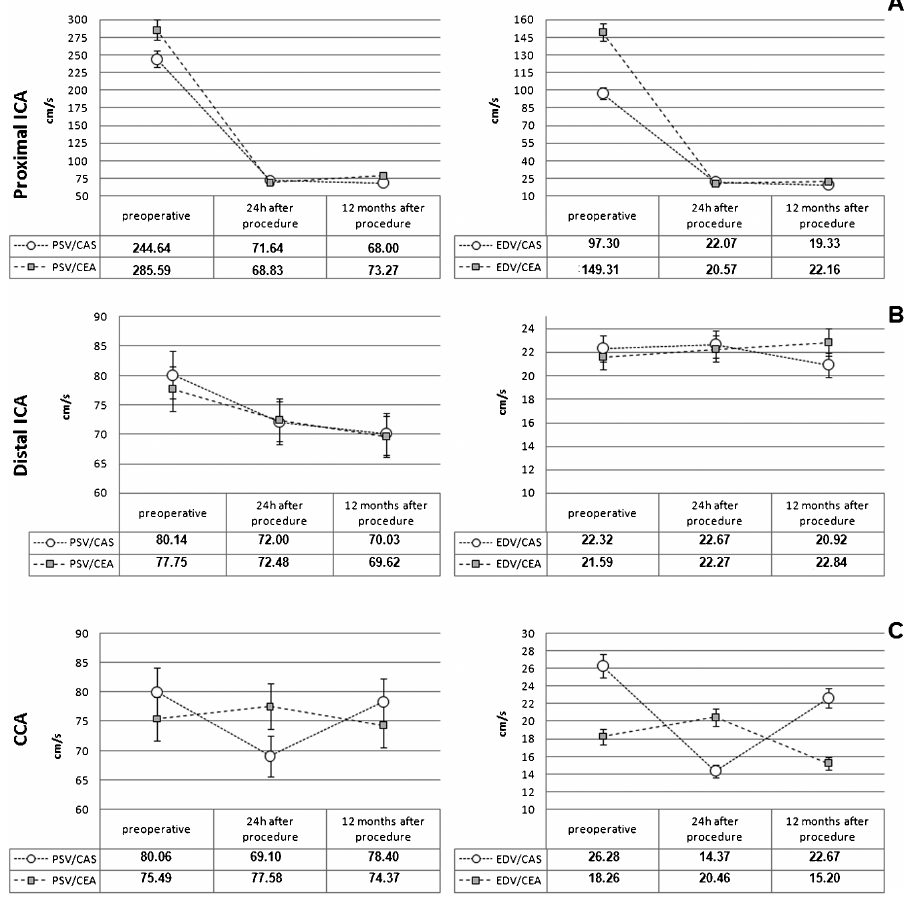
Figure 2 – Mean duplex-velocities (PSV and EDV, cm/s) through the p-ICA (a), d-ICA (b) and CCA (c) over the follow-up period. PSV: peak systolic velocity; EDV: end diastolic velocity; p-ICA: proximal internal carotid artery; d-ICA: distal internal carotid artery; CCA: common carotid artery; CAS: carotid artery stenting; CEA: carotid